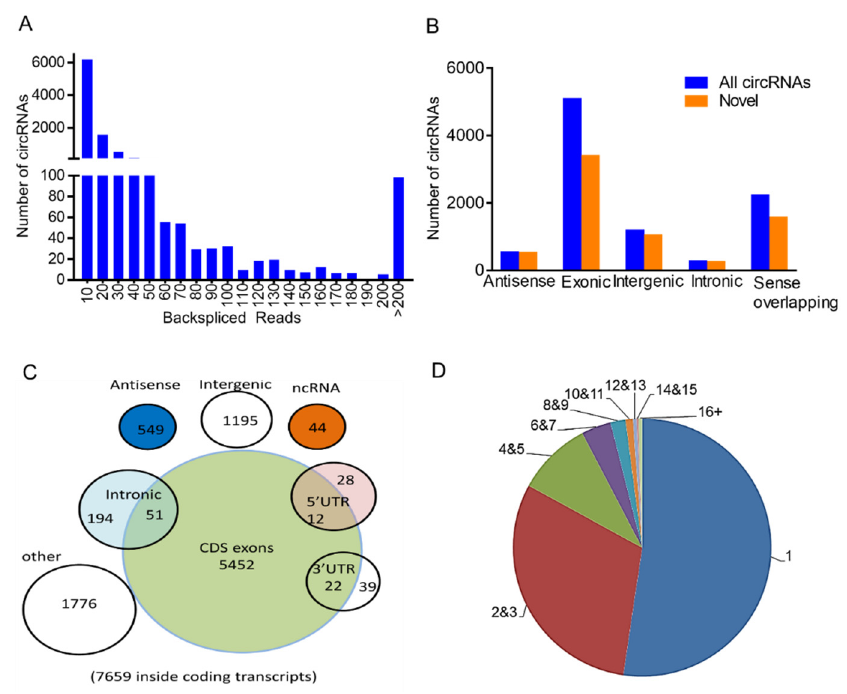
Figure 2. Expression profiles of circular RNAs (circRNAs) in porcine granulosa cells in HA and AA follicles. ( A ) A number of circRNAs with different back-spliced reads. ( B ) A number of newly discovered circRNAs among different types of circRNAs. ( C ) Genomic origin of identified porcine circRNAs. ( D ) A number of circRNAs produced from one gene. HA, healthy antral follicles; AA, atretic antral follicles. Follicles were isolated in batches at three different time points, each batch containing 15 – 20 ovaries.